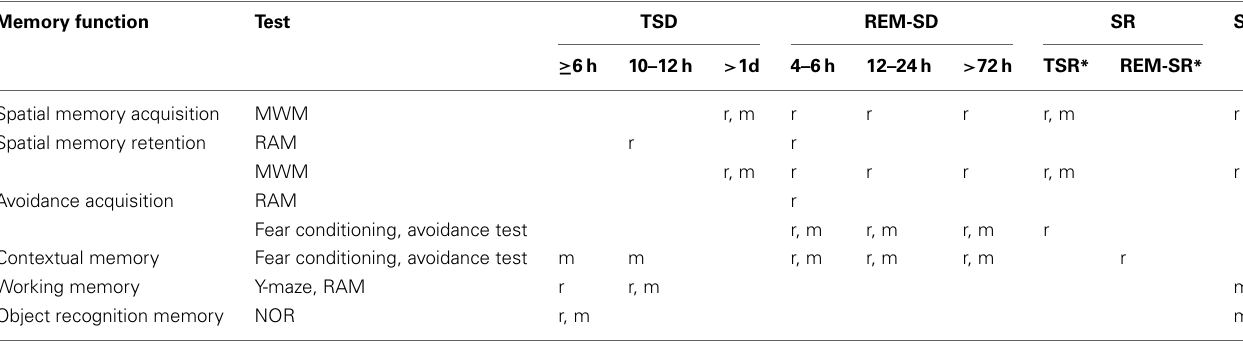
Table 1 | Synopsis of impairments in memory function after sleep deprivation in laboratory rats and mice. Memory